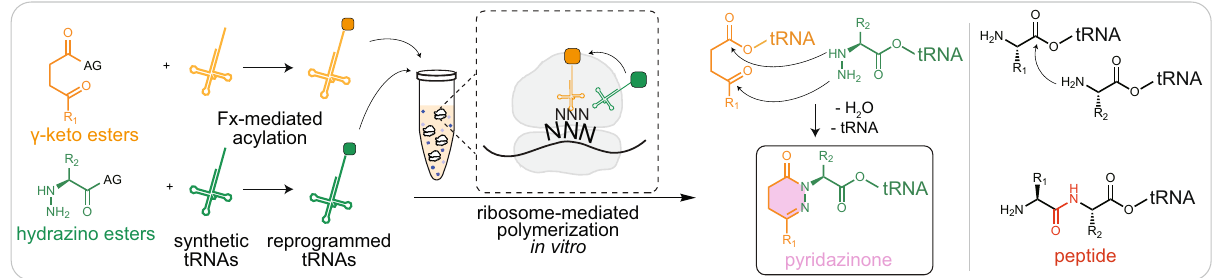
Fig. 1 | Ribosome-catalyzed formation of pyridazinone bonds in vitro. Genetic code reprogramming using the fl exizyme system enables the acylation of non- canonical substrates with tRNA. Upon fl exizyme-mediated tRNA acylation of keto (orange) and hydrazino (green) activated esters, the programmed keto-tRNA (orange) and hydrazinyl-tRNA (green) were added to an in vitro transcription and